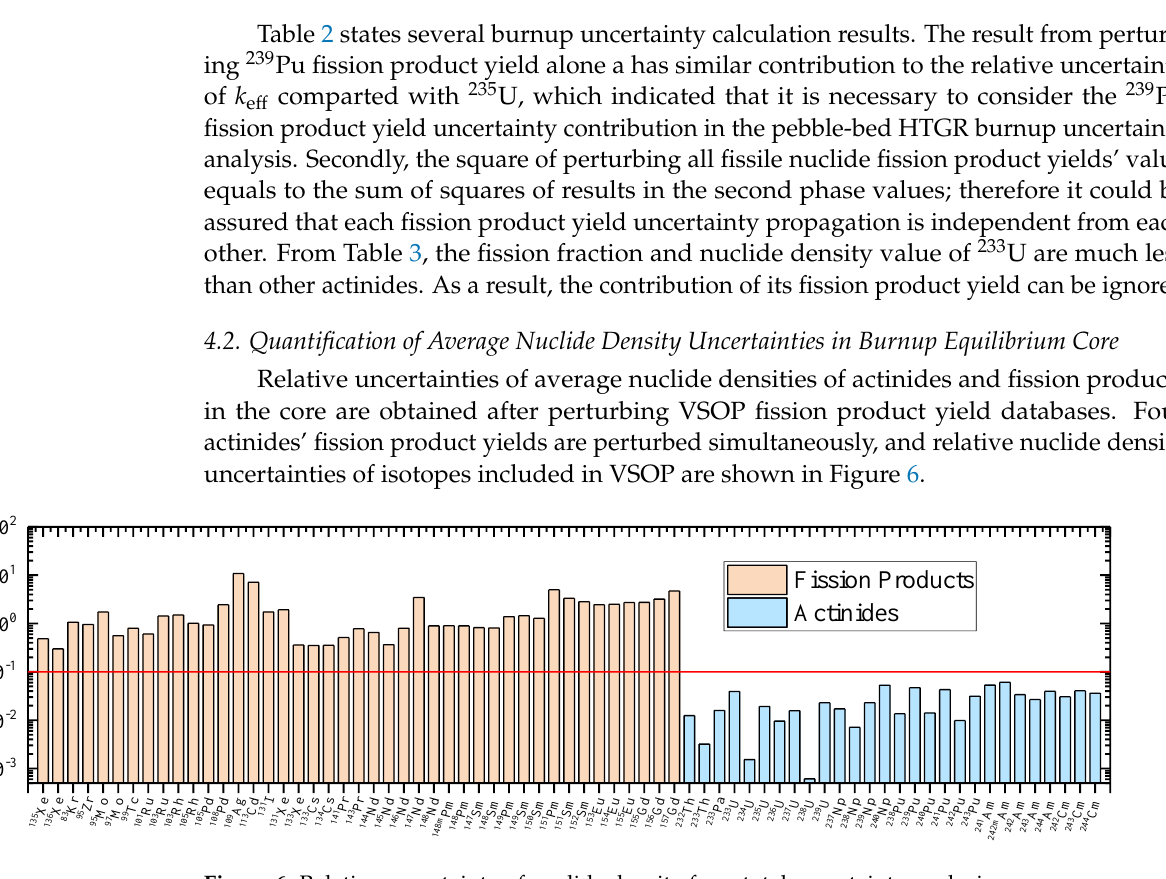
Figure 6. Relative uncertainty of nuclide density from total uncertainty analysis.